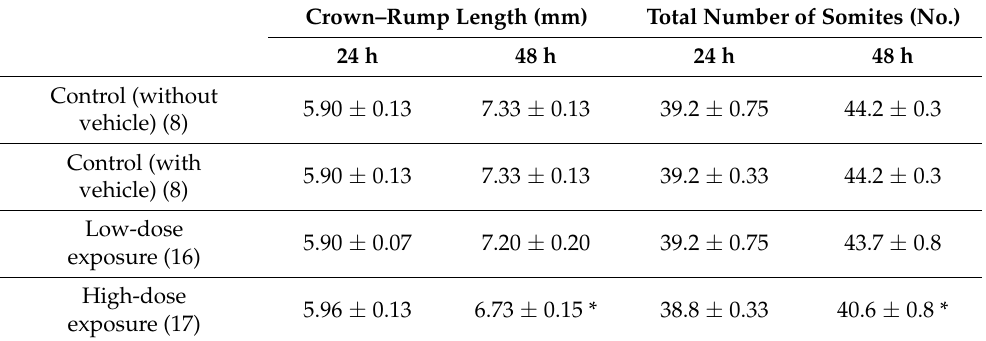
Table 2. Crown–rump length and total number of somites of rat embryos cultured for 24 and 48 h.